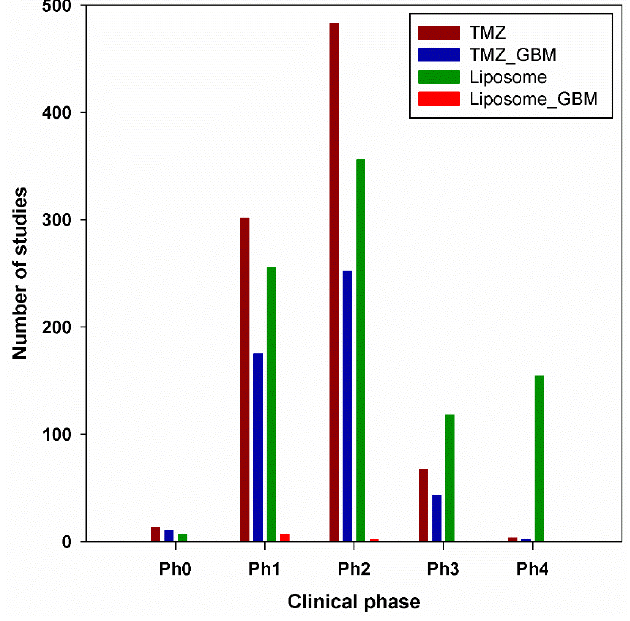
Figure 12. Clinical trials on TMZ and liposomes.